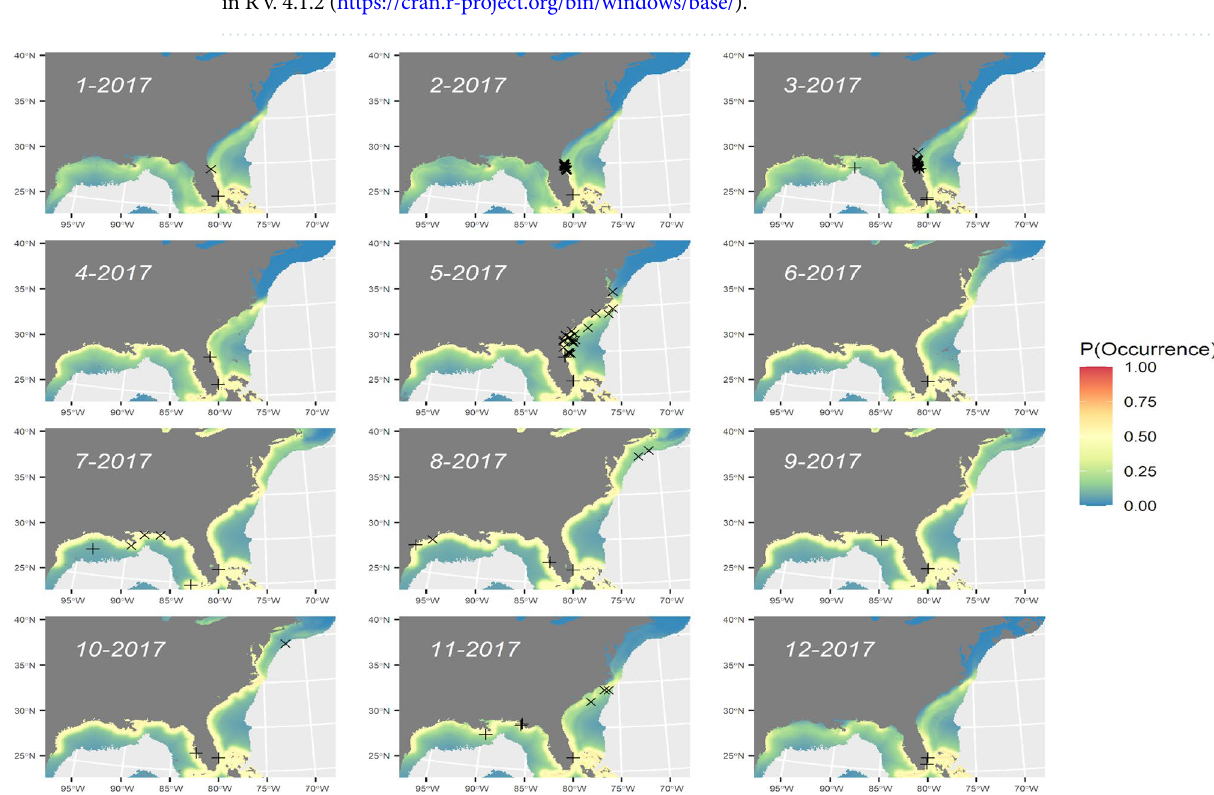
Figure 4. Predicted probability of occurrence for manta rays by a weighted ensemble of model predictions from SEFSC, NARWC, and NYSERDA surveys for monthly average environmental conditions in 2017 with overlay of internal (X) and external (+) validation points. Map generated in R v. 4.1.2 (https:// cran.r- proje ct. org/ bin/ windo ws/